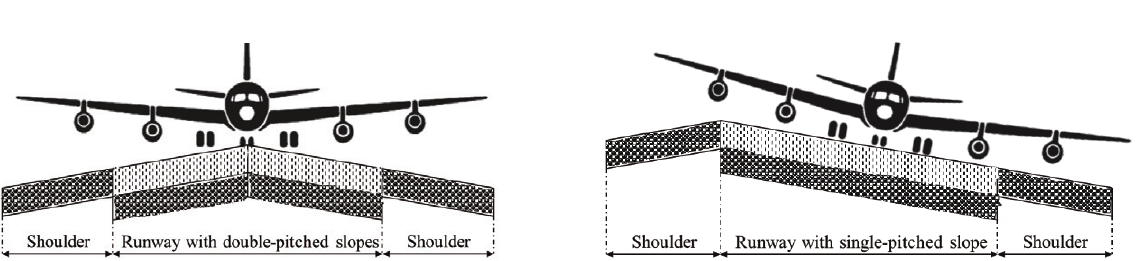
Figure 4. Execution methods of runway transverse slopes; doubled-pitched and